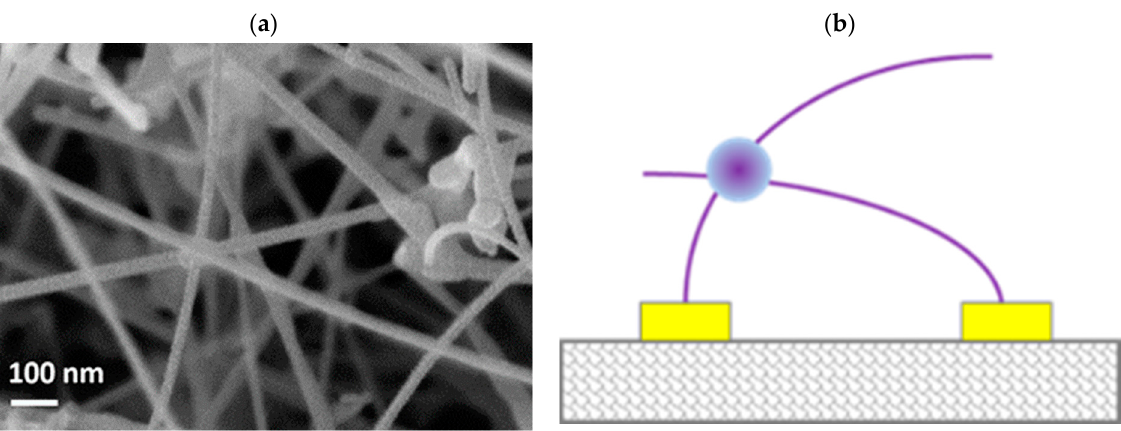
Figure 1. ( a ) SLV-deposited SnO 2 nanowire array, ( b ) current flow across nanowire network.